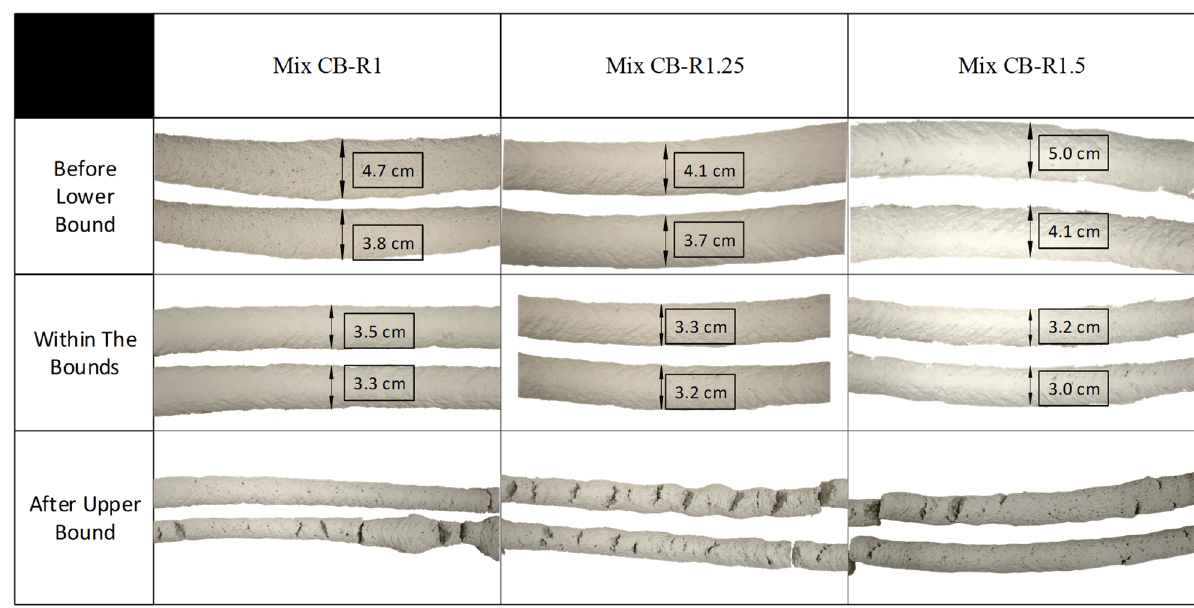
Figure 7. Evolution of shear stress for mixes 1, 2, and 3.